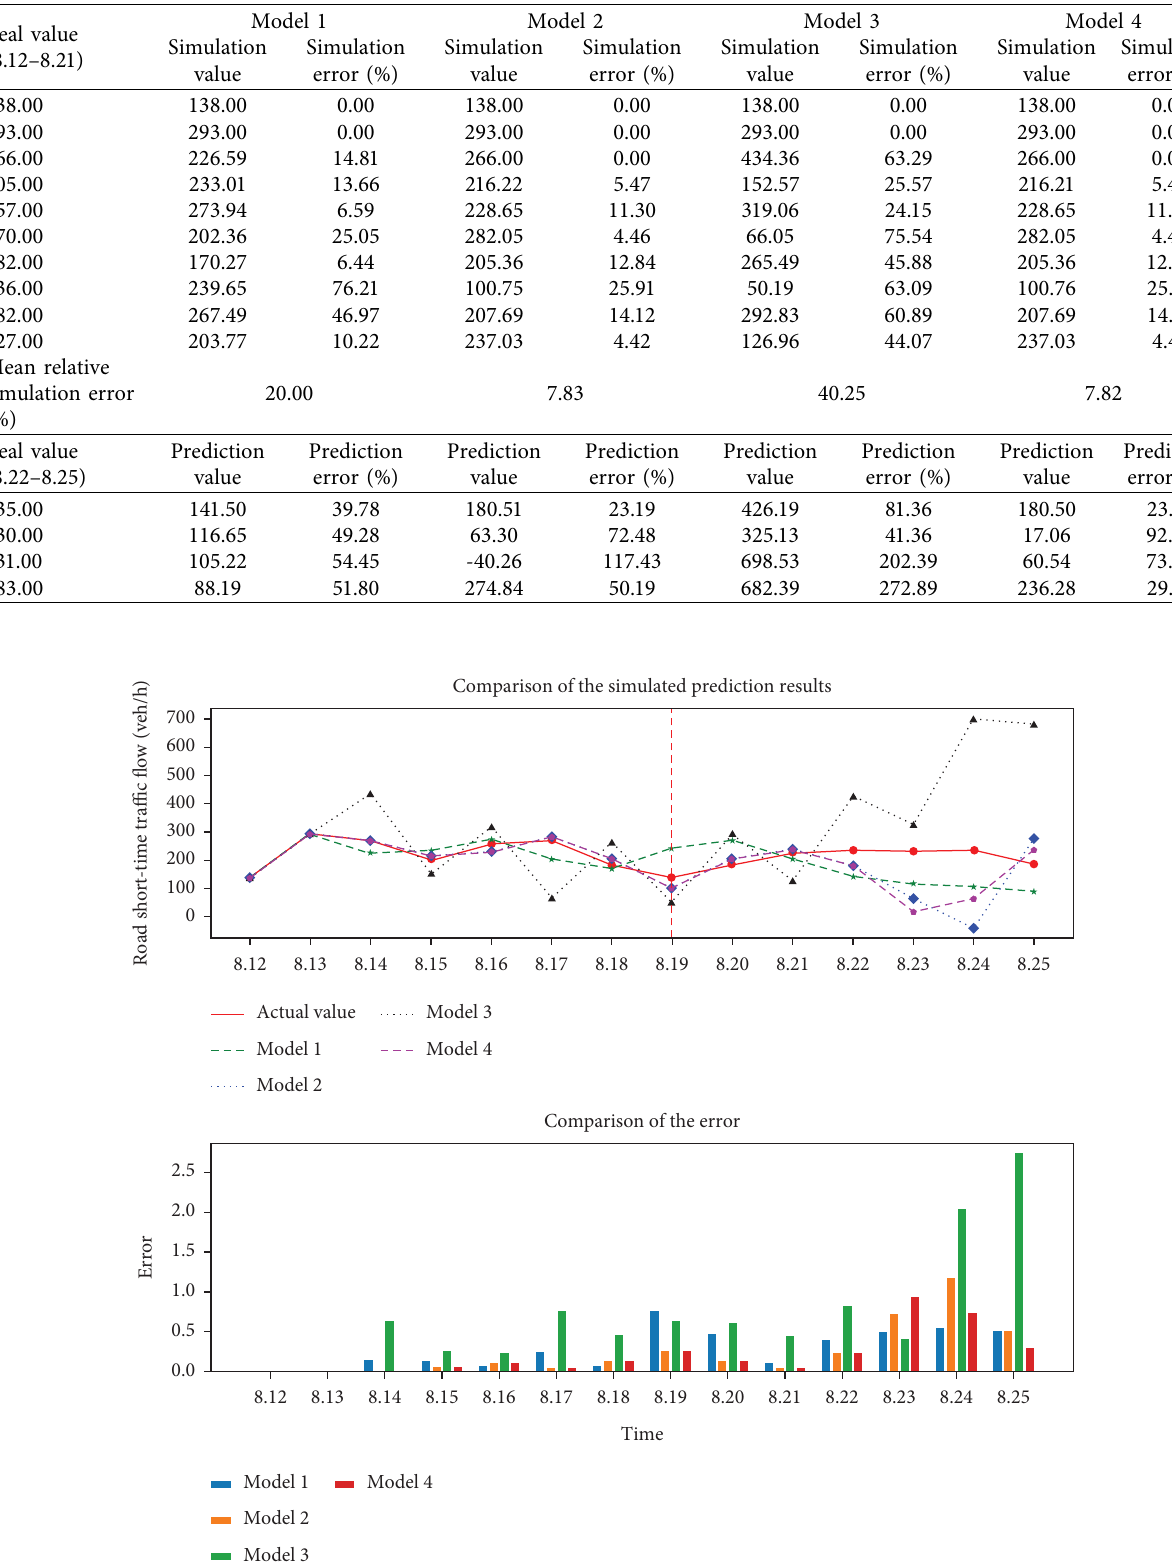
Figure 7: Schematic diagram of the predicted value of the four models on short-time trafc